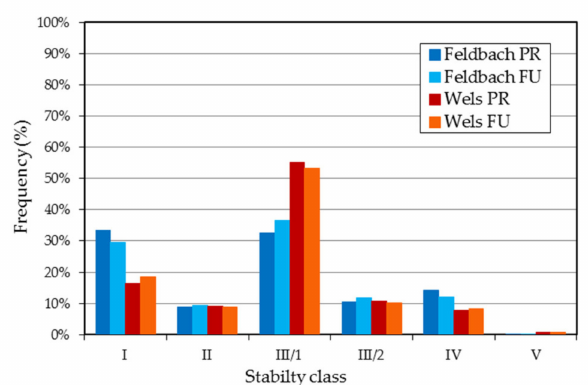
Figure 6. Frequency distribution of EPA stability classes determined according to Table 1 at Feldbach and Wels (PR—present (1981–2010); FU—future